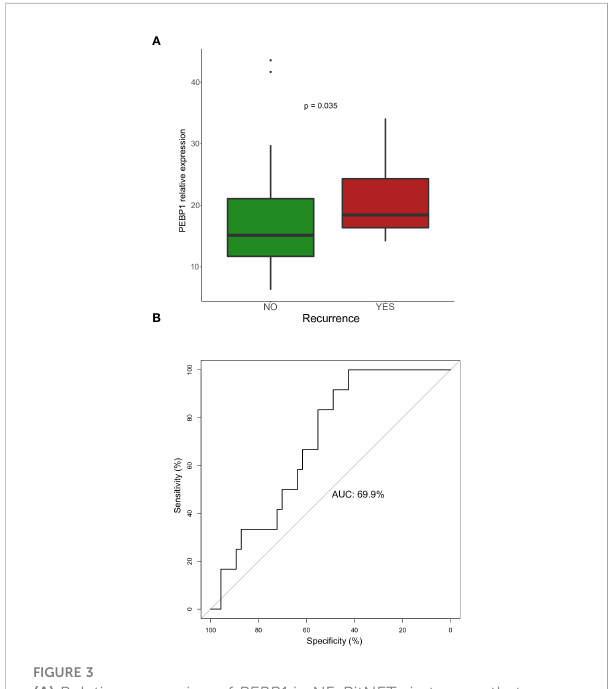
FIGURE 3 (A) Relative expression of PEBP1 in NF-PitNETs in tumors that recurred vs. tumors that did not. (B) ROC curve for predicting recurrence using ARRB1 expression in